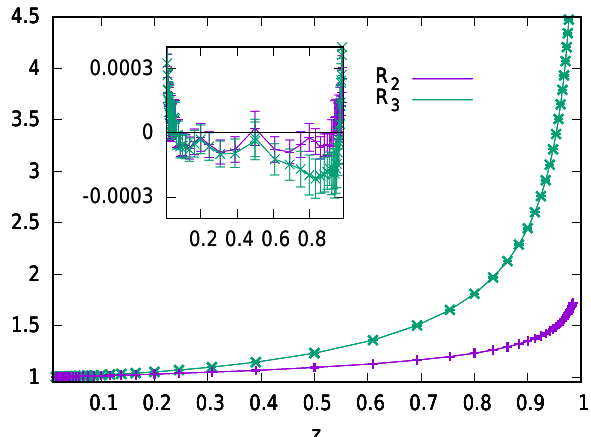
, R (lines) with the corresponding combinations of connec- 2 3